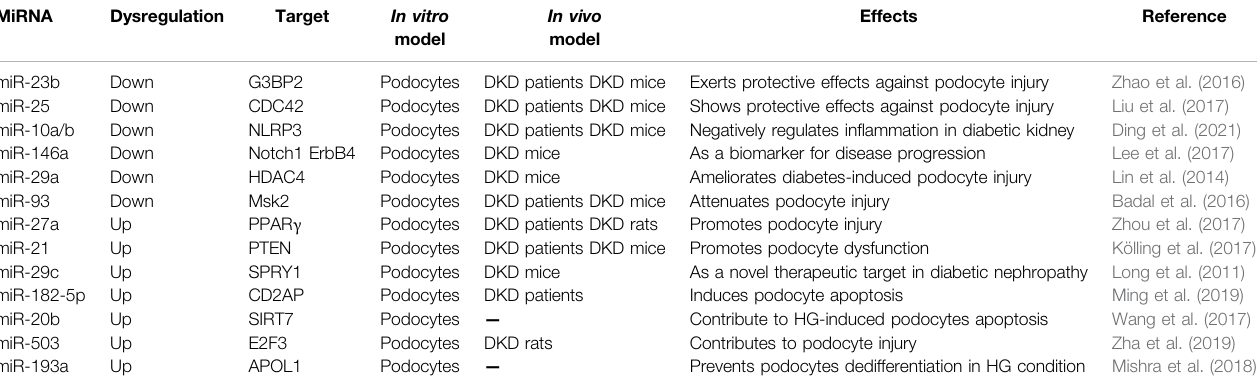
TABLE 4 | MiRNAs in diabetic kidney disease. MiRNA